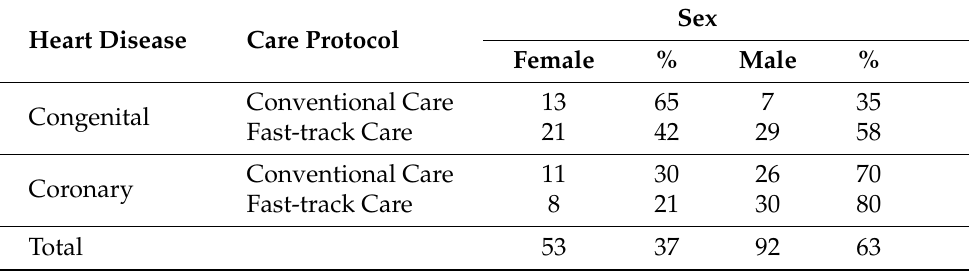
Table 2. Absolute and relative distribution for sex of patients with congenital and coronary heart disease followed up in both